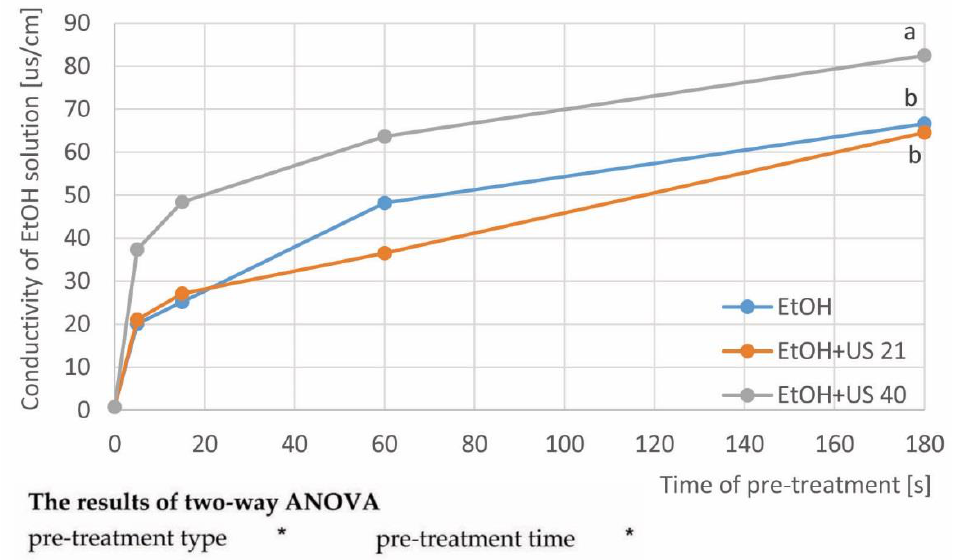
Figure 1. Conductivity of the ethanol solution after carrot pre-treatment without and with ultrasound (21 and 40 kHz): a, b, etc.—different letters indicate different homogeneous groups (one-way ANOVA, α = 0.05).